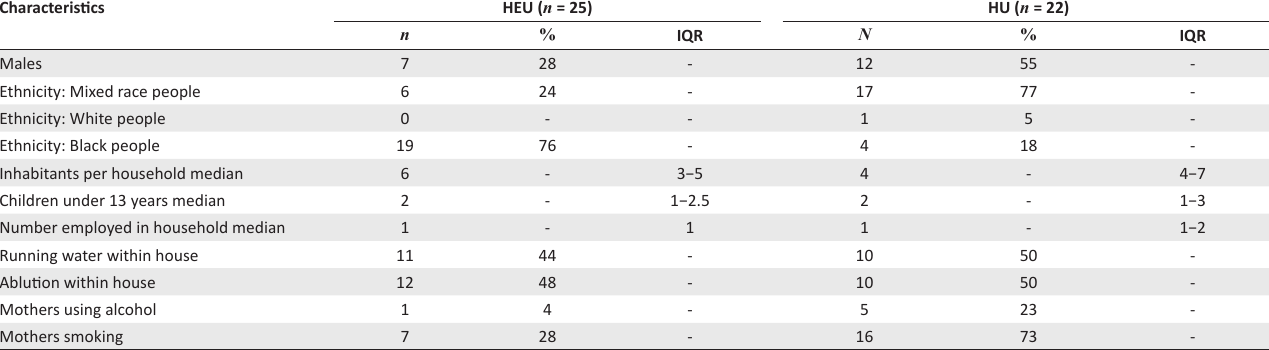
TABLE 1: Sociodemographic characteristics of HIV-exposed uninfected and HIV-unexposed infants at enrolment in nutrition study at 6 months of age. Characteristics HEU ( n = 25)